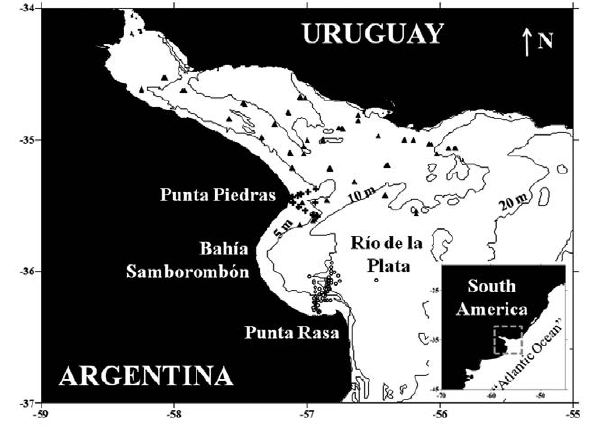
Fig. 1. – Location of the stations used to determine the relation- ship between SPM and turbidity. Samples were collected during six cruises in the mid-estuary during research cruise FREPLATA- FFEM (triangles), two research cruises in Punta Piedras (crosses) and seven research cruises in Punta Rasa